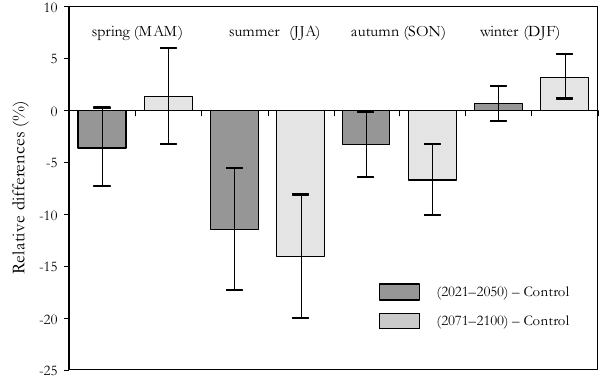
Figure 6. Averages and standard deviations of relative differences between ozone deposition velocities in each period.